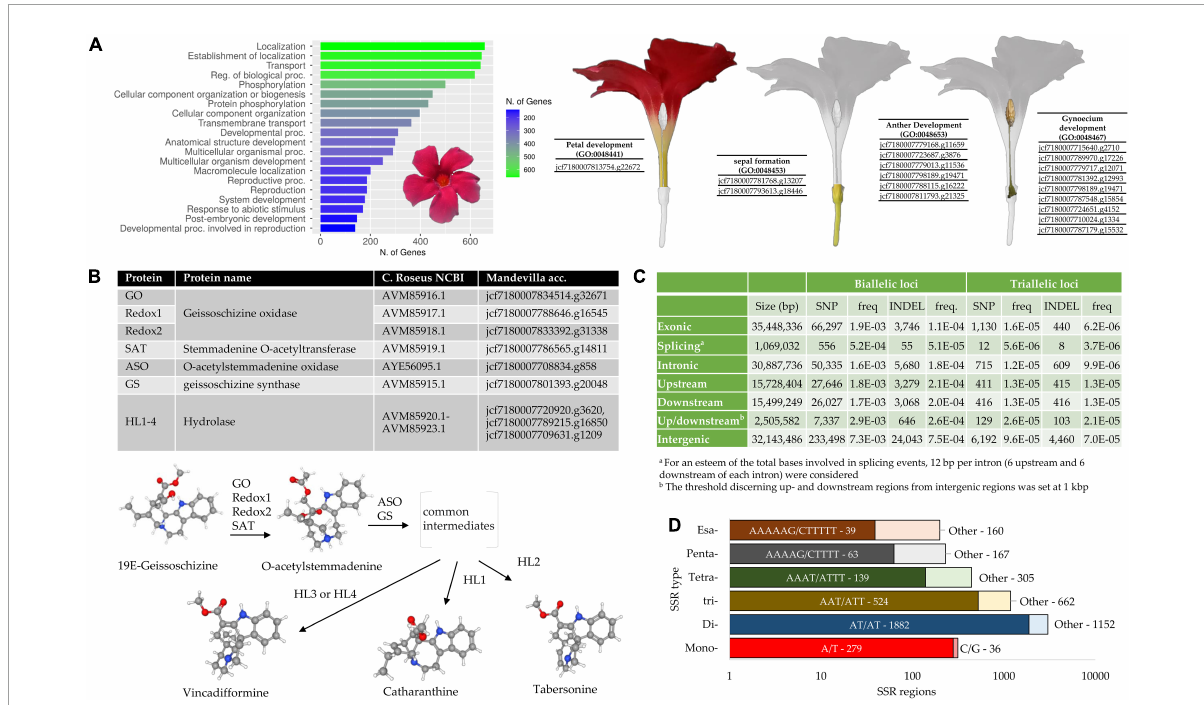
FIGURE3 (A) GO enrichment analysis of the Mandevilla proteome based on the Coffea canephora proteome (Rubiaceae family, Gentianales order, GCA_900059795.1). The top 20 Biological Process (BP) categories (in terms of genes number) are reported. The 186 proteins involved in the “reproductive process GO:0022414” and “reproduction GO:0000001” categories were further investigated to identify amino acid sequences specifically involved in floral tissues development. (B) Identification of putative enzymes involved in the biosynthesis of catharanthine, tabersonine and vincadifformine. A BLASTp analysis was performed by aligning 10 amino acid sequences from Catharanthus roseus involved in the production of the abovementioned MIAs (monoterpene indole alkaloids) against the predicted Mandevilla proteome. In the bottom part of the panel, the last steps leading to the production of catharanthine, tabersonine and vincadifformine are illustrated according to Qu et al. (2019); (C) Biallelic and triallelic loci (SNP and INDEL) detected within the newly assembled genome, classified according to their location. Frequencies are also provided and they were calculated as the number of loci divided by the total length of each category (second column); (D) Detailed abundance of microsatellites in the newly assembled genome of Mandevilla. The most abundant motif for each SSR type is